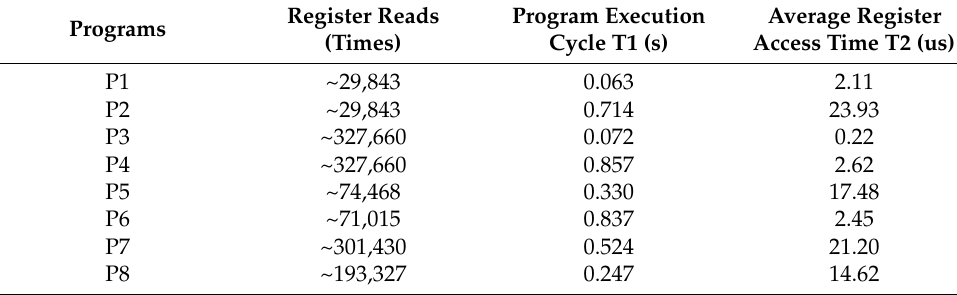
Table 1. Statistics of register usage under eight test programs.